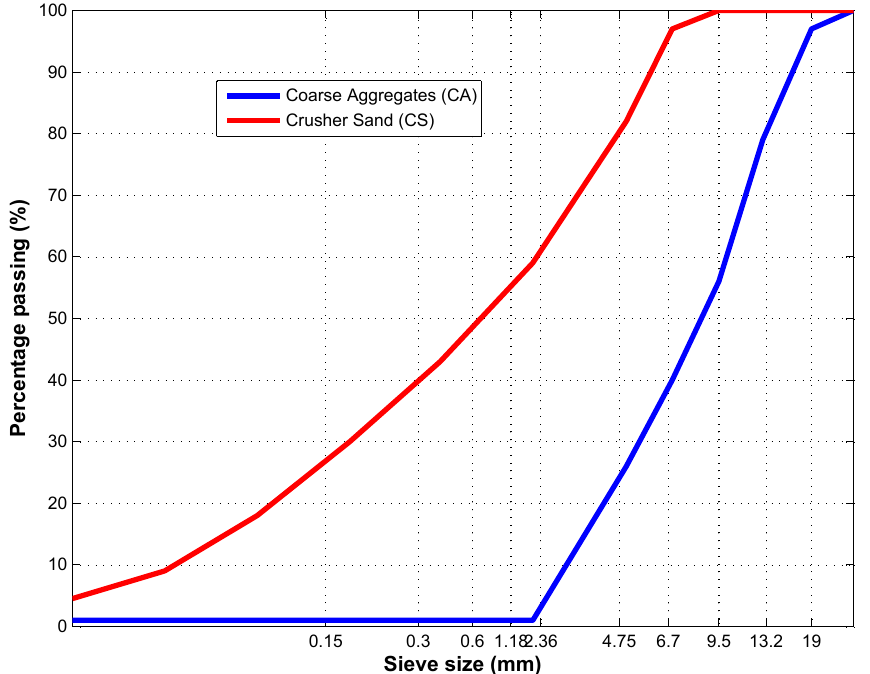
Figure 2. Grading curves for fine and coarse